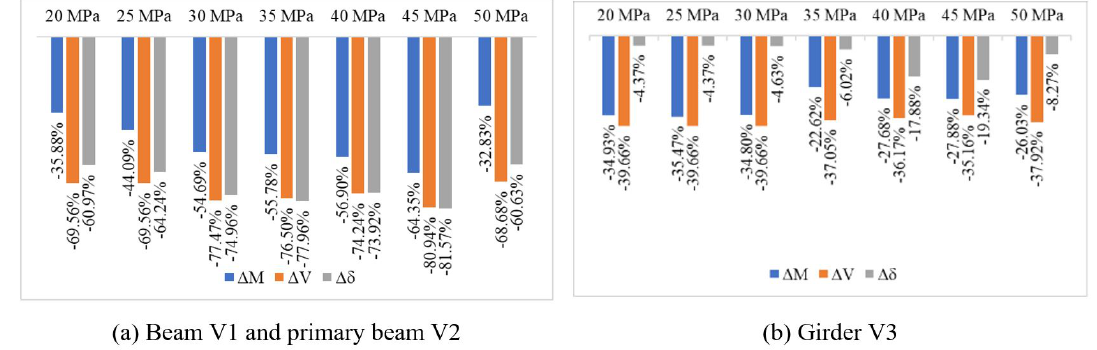
Figure 11. Verification of SLS and